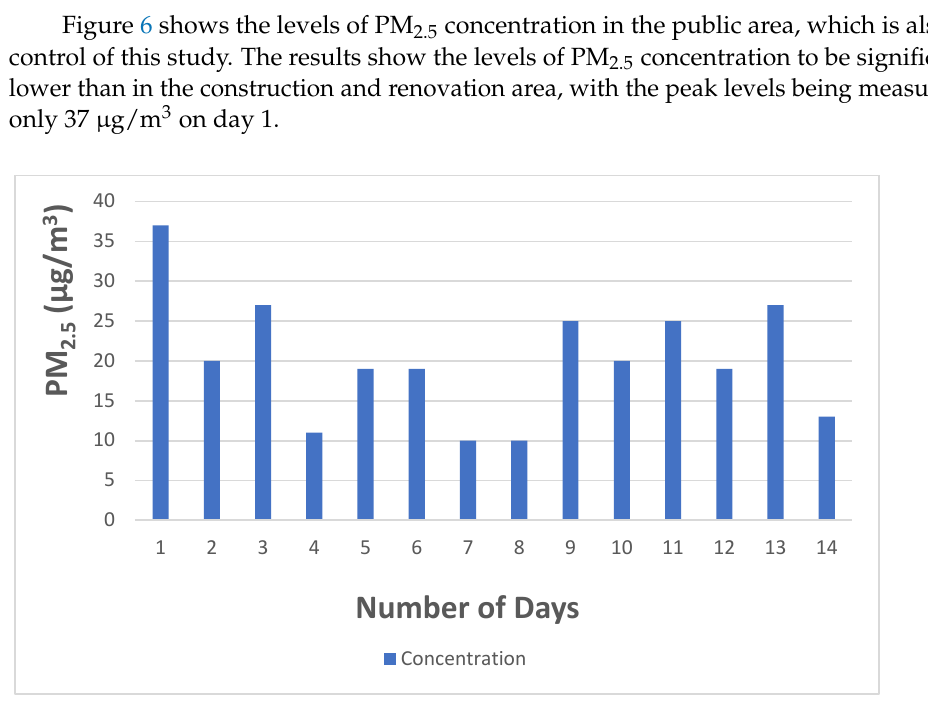
Figure 6. The levels of PM 2.5 concentration in the public area throughout a 14-day monitoring campaign in a large shopping mall .